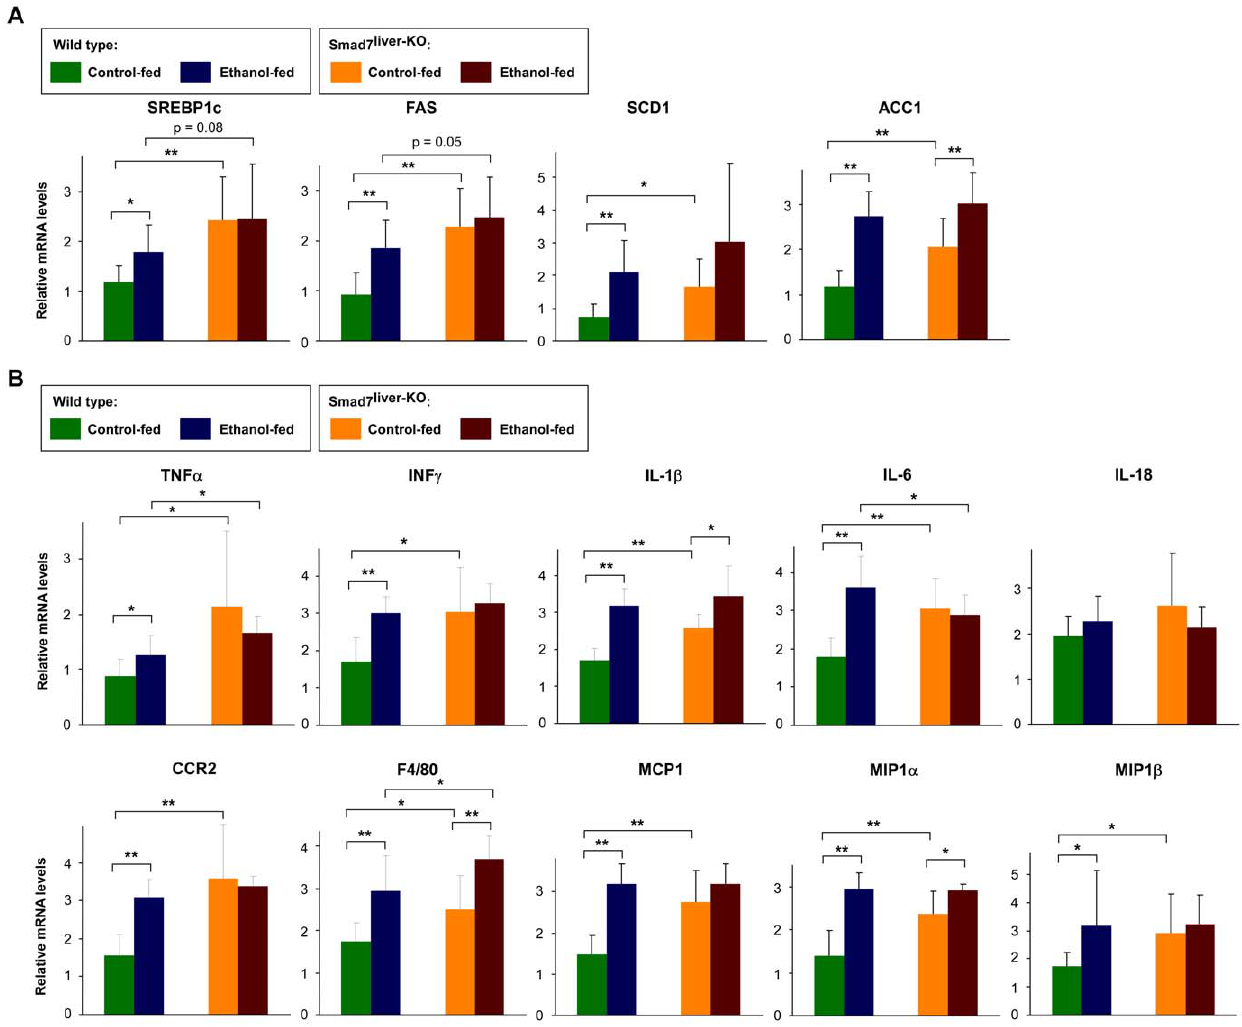
Figure 7. Upregulation of lipogenesis- and inflammation-related genes by ethanol treatment and Smad7 deletion. (A) Analysis of the mRNA levels of critical lipogenic genes of the mouse liver by real-time RT-PCR. Alcohol-feeding of the mice was as described in Figure 5A. The data are shown as mean 6 SD. * and ** indicates p , 0.05 and p , 0.01 respectively. (B) Analysis of the mRNA levels of a series of inflammation-related factors by real-time RT-PCR with the samples as in Figure 5A. The data are shown as mean 6 SD with * for p , 0.05 and ** for p , 0.01 between the groups as indicated.